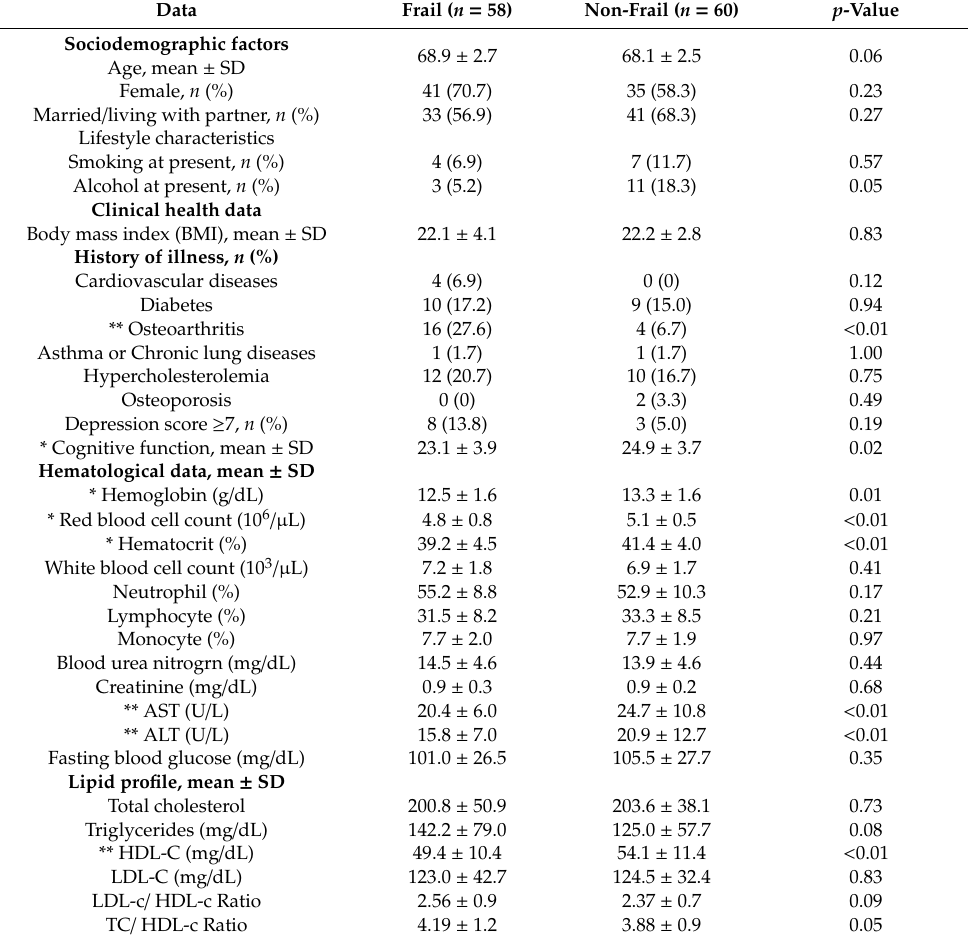
Table 2. Characteristics of volunteer participants according to frailty status ( n = 118).